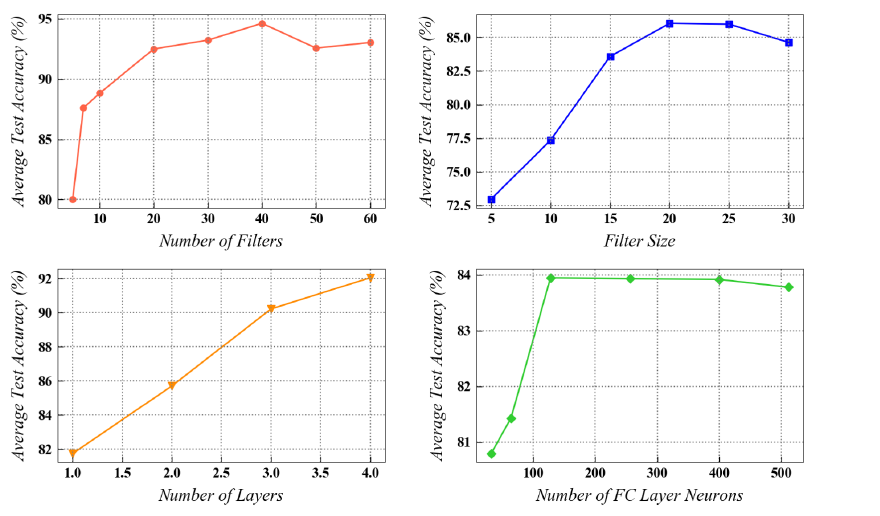
Figure 5. The effect of four hyperparameters on the performance of the network in task T 1 of CWRU